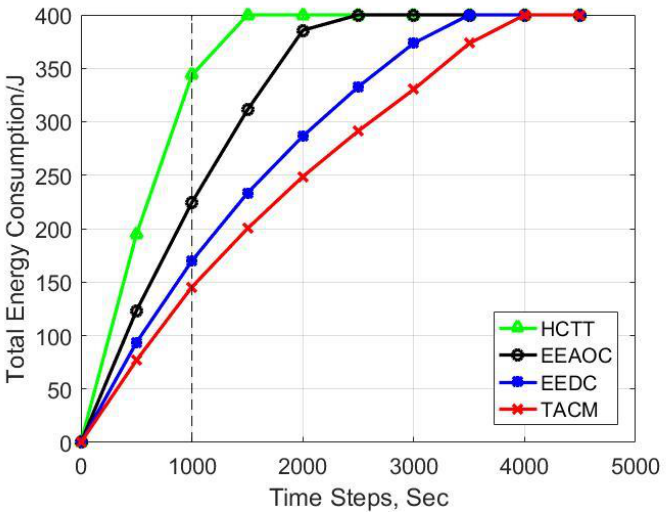
Figure 10. Experimental results for total energy consumption in the network.